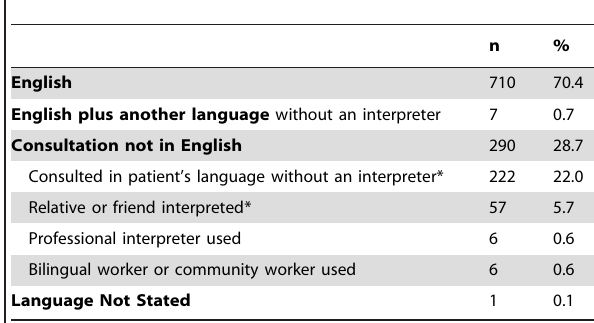
Table 4. Consultation